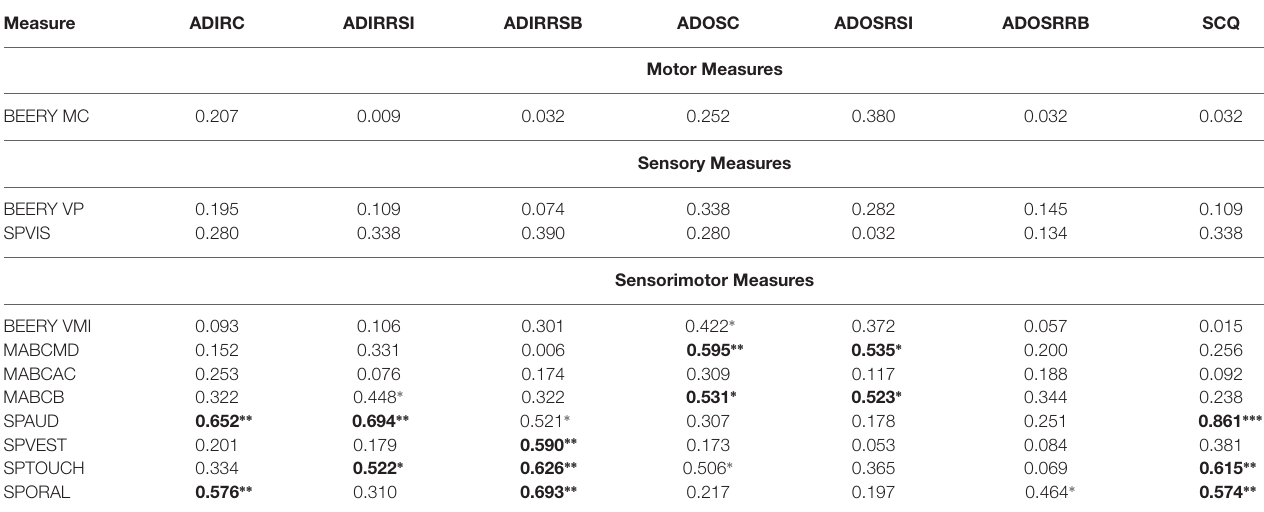
TABLE 6 | Correlation analysis ( r ) for specific autism components, coordination components and sensory components in ASC group ( n = 18).